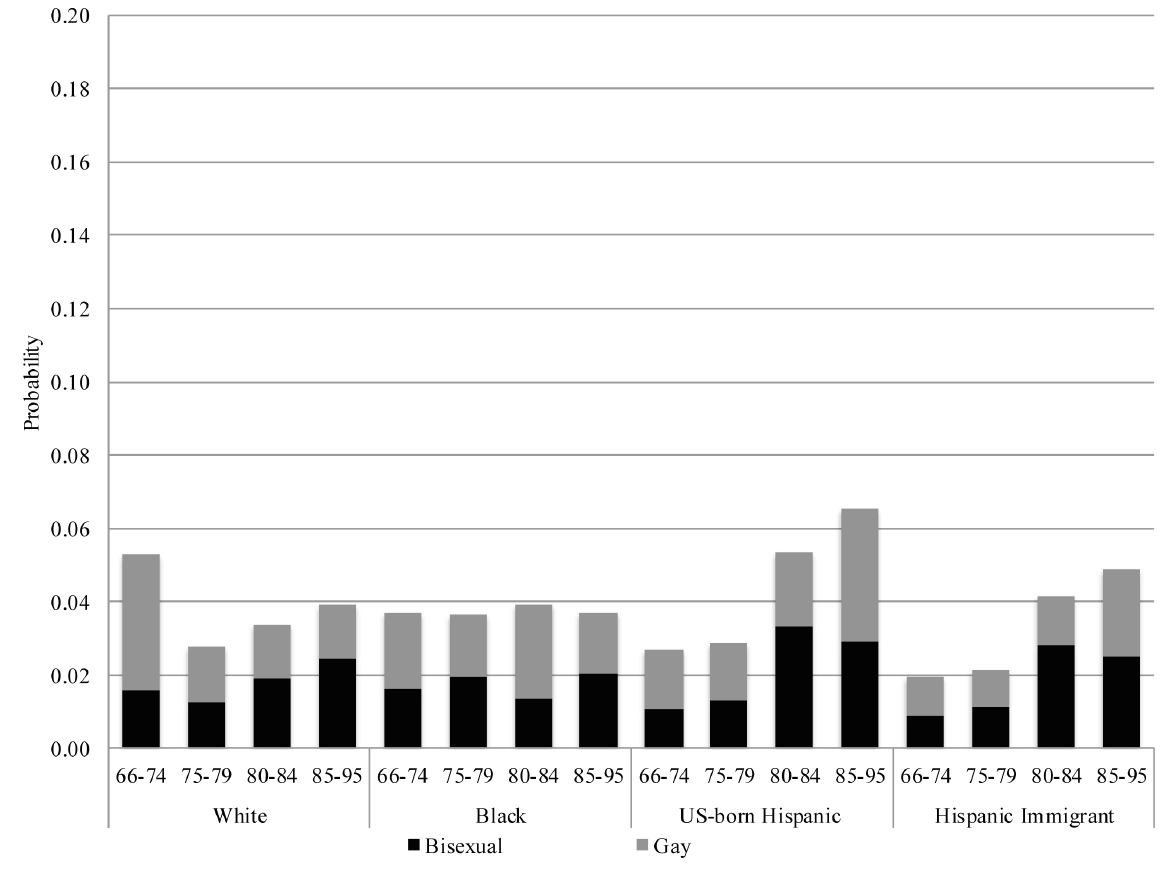
Figure 6: Men’s predicted probability of identifying as bisexual or gay, by birth cohort and